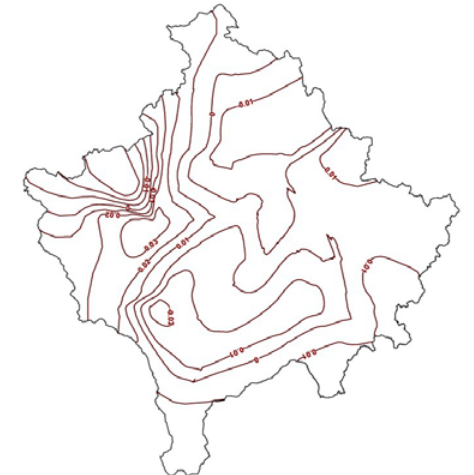
Fig. 5. Difference model (In meters) calculated from EGM2008 and EGG97